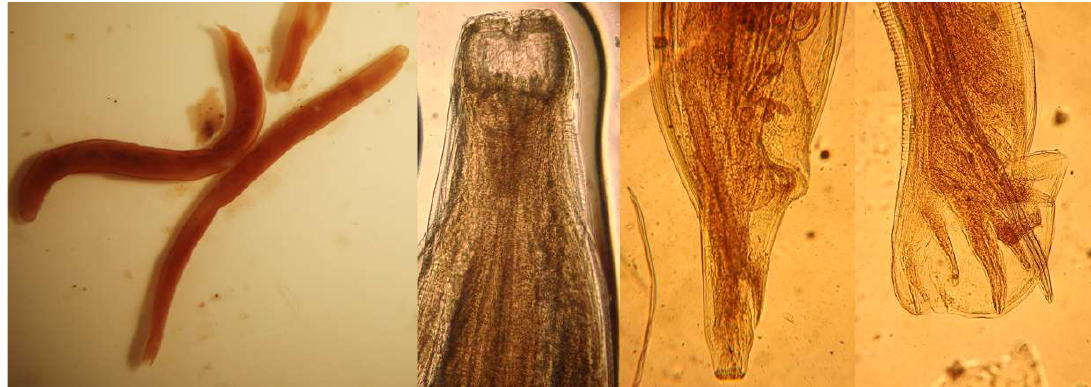
Figure 5. (left to right) adult Ternidens deminutus whole female and male worms from a human; anterior of an adult showing the buccal capsule, posterior of an adult female; posterior of an adult male showing copulatory bursa (photographs by Richard Bradbury).